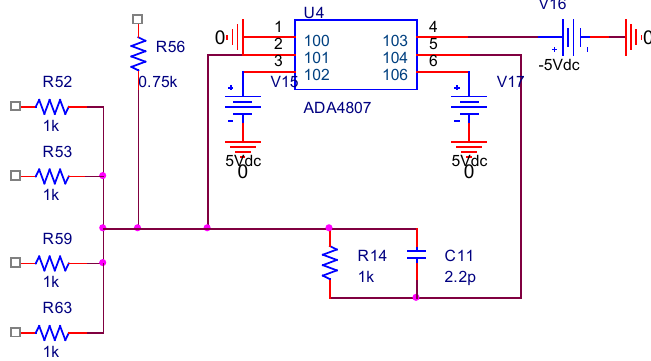
Figure 16. Integrated circuit of the open high-frequency Rogowski coil current sensor. The high-frequency signal above 116 kHz can be integrated.